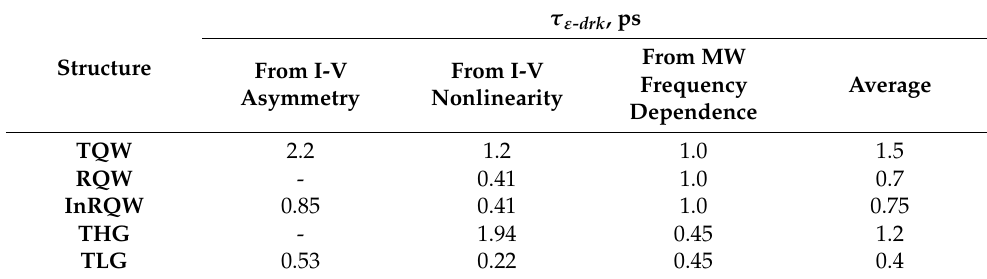
Table 6. Electron energy relaxation time τ ε -drk evaluated using I-V asymmetry, I-V nonlinearity,